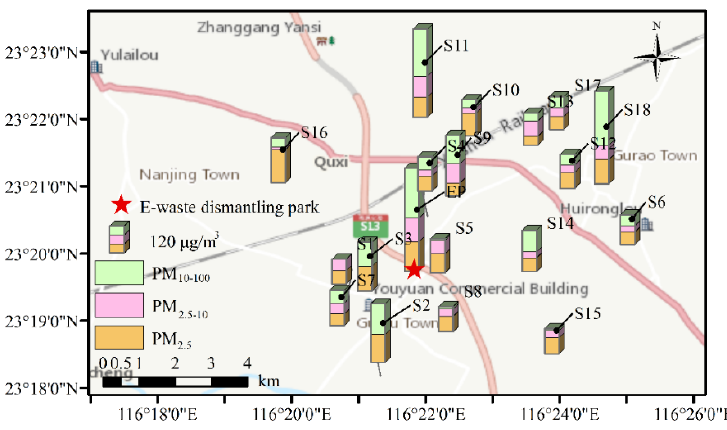
Figure 1. The spatial map of PM 2.5 , PM 2.5–10 , and PM 10–100 concentrations in the e-waste dismantling park and the surrounding residential area. S1–S18 and EP were labels of sampling points.